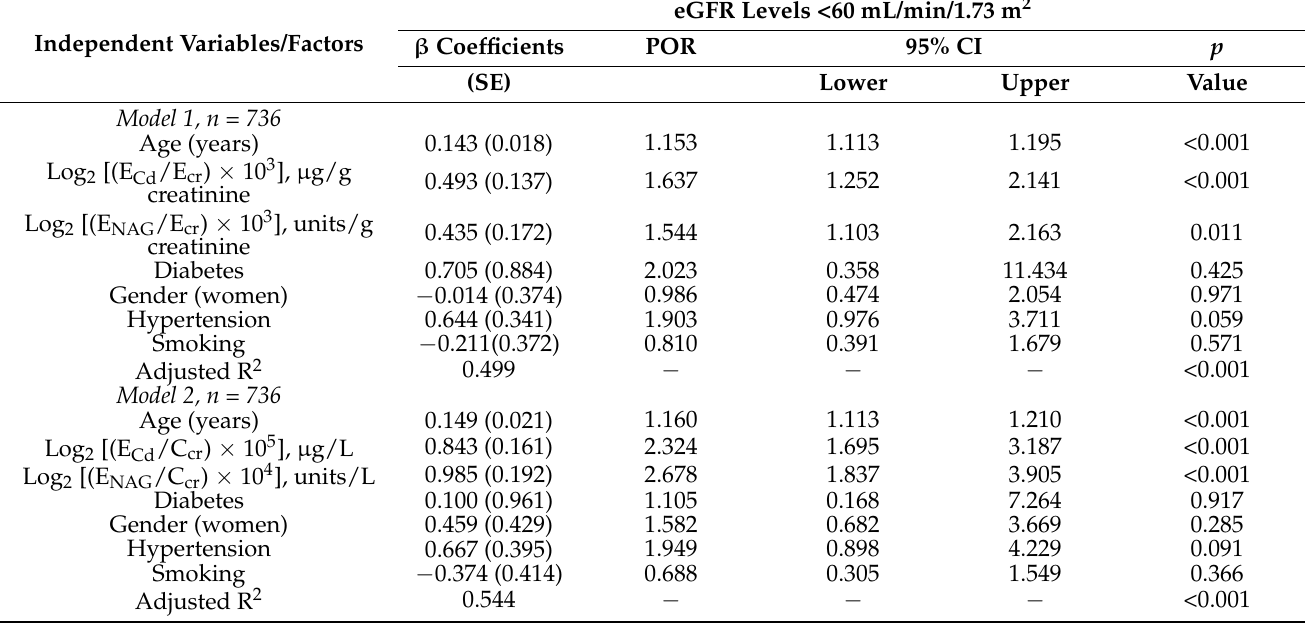
POR = Prevalence Odds Ratio; S.E. = Standard error of mean; Data were generated from logistic regression analyses relating POR for CKD to independent variables. Independent variables are listed in the first column. CKD was defined as eGFR <60 mL/min/1.73m 2 . p -Values < 0.05 indicate a statistically significant increase in POR for CKD. Log 2 [(E Cd /E cr ) × 10 3 ] and log 2 [(E NAG /E cr ) × 10 3 ] were incorporated into model 1; log values were obtained by univariate analyses that incorporated eGFR as a continuous variable. Independent variables were identical to those used in the logistic regression